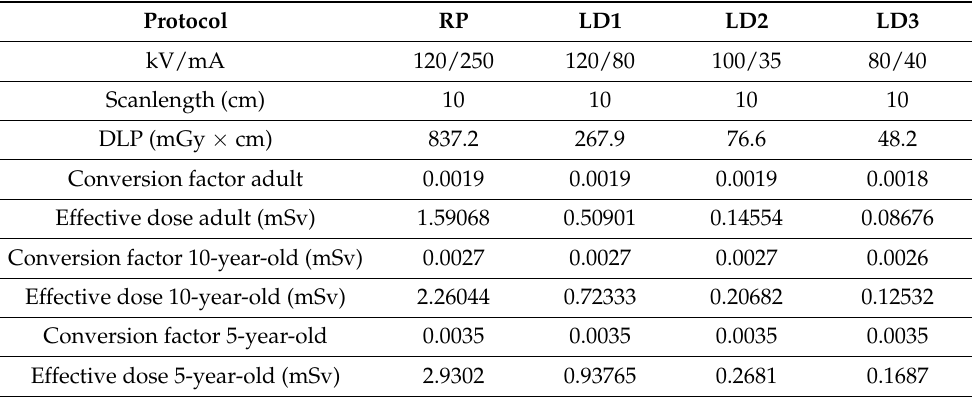
Table 2. Conversion factors from DLP to effective dose as a function of voltage, region, and age as per ICRP Publication 103. 2007 Recommendations of the International Commission on Radiological Protection. DLP = dose length